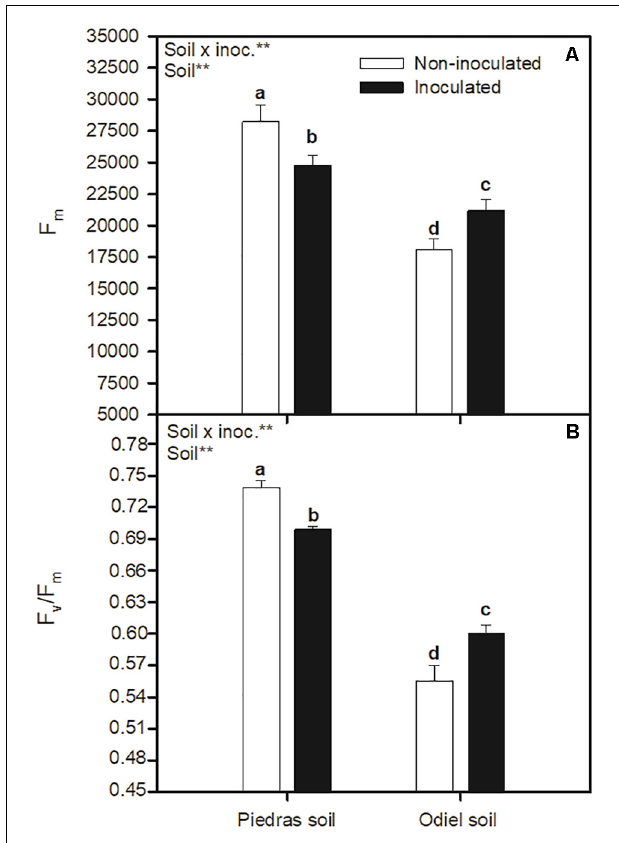
FIGURE 3 | Effect of soil bioaugmentation on S. ramosissima (A) maximal fluorescence level in the dark-adapted State, F m , and (B) maximum quantum efficiency of PSII photochemistry, F v /F m , after 30 days of treatment. Values are means ± S.E. ( n = 10). “Inoc” or “Soil” in the upper left corner of the panel indicates main or interaction significant effect (** p < 0.01). Different letters indicate means that are significantly different from each other ( p <